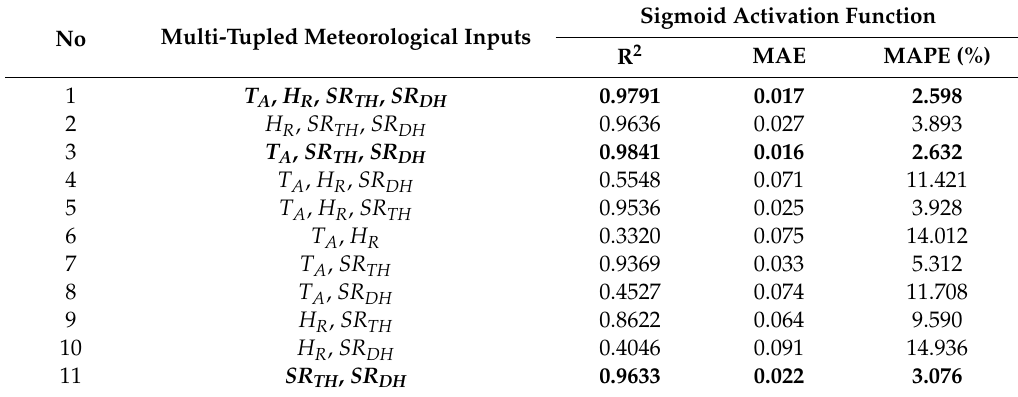
Table 1. Daily photovoltaic power prediction results of the GWO-MLP method, which used the sigmoid activation